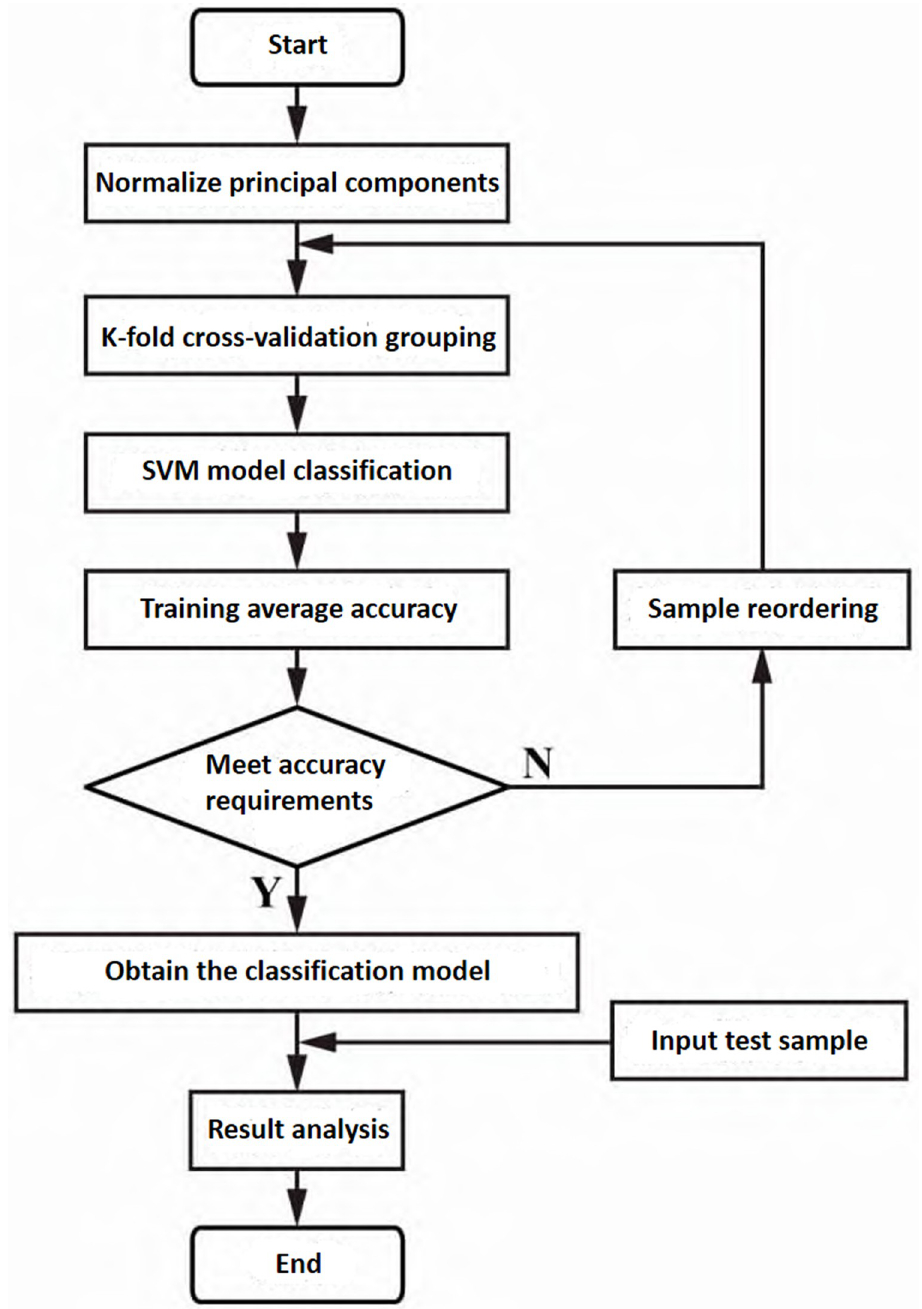
Fig 6. Flow chart of realization of SVM origin identification model of Cornus officinalis based on K-fold cross- validation. samples) data as a training set, so that 10 training model data will be obtained and brought into the SVM model for training. (iv) When the average accuracy rate of the model is greater than or equal to 80%, it is determined that the model can identify the origin of Cornus officina- lis , and the optimal result of the training model is determined as the classification model. If the